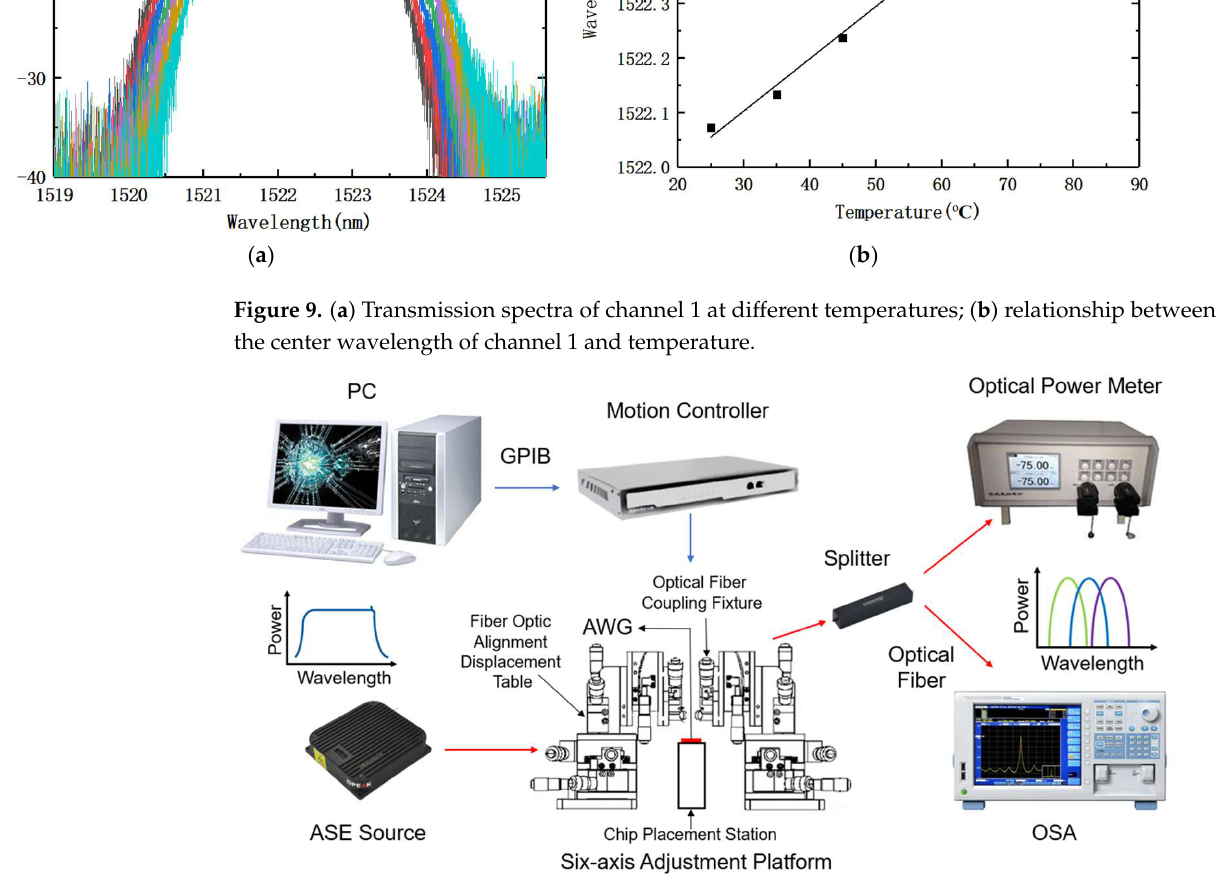
Figure 9. ( a ) Transmission spectra of channel 1 at different temperatures; ( b ) relationship between the center wavelength of channel 1 and temperature.